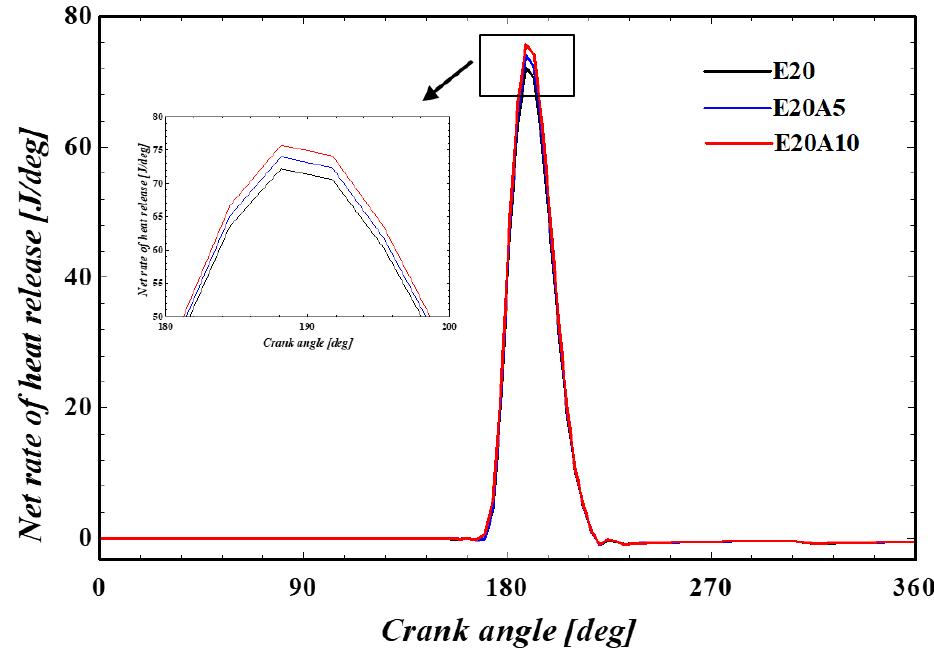
Figure 10. The net rate of heat release in various crank angles at engine rated RPM.